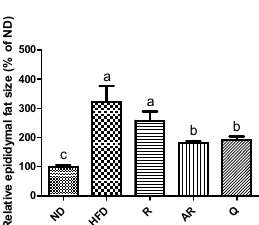
Figure 1. Histological analysis of liver ( A ) and epididymal ( B ) tissue in mice fed with experimental diets for 7 weeks. ND, normal diet; HFD, high-fat diet; R, high-fat diet with 100 mg/kg rutin/day; AR, high-fat diet with 100 mg/kg acid-treated rutin/day; Q, high-fat diet with 100 mg/kg quercetin/day.